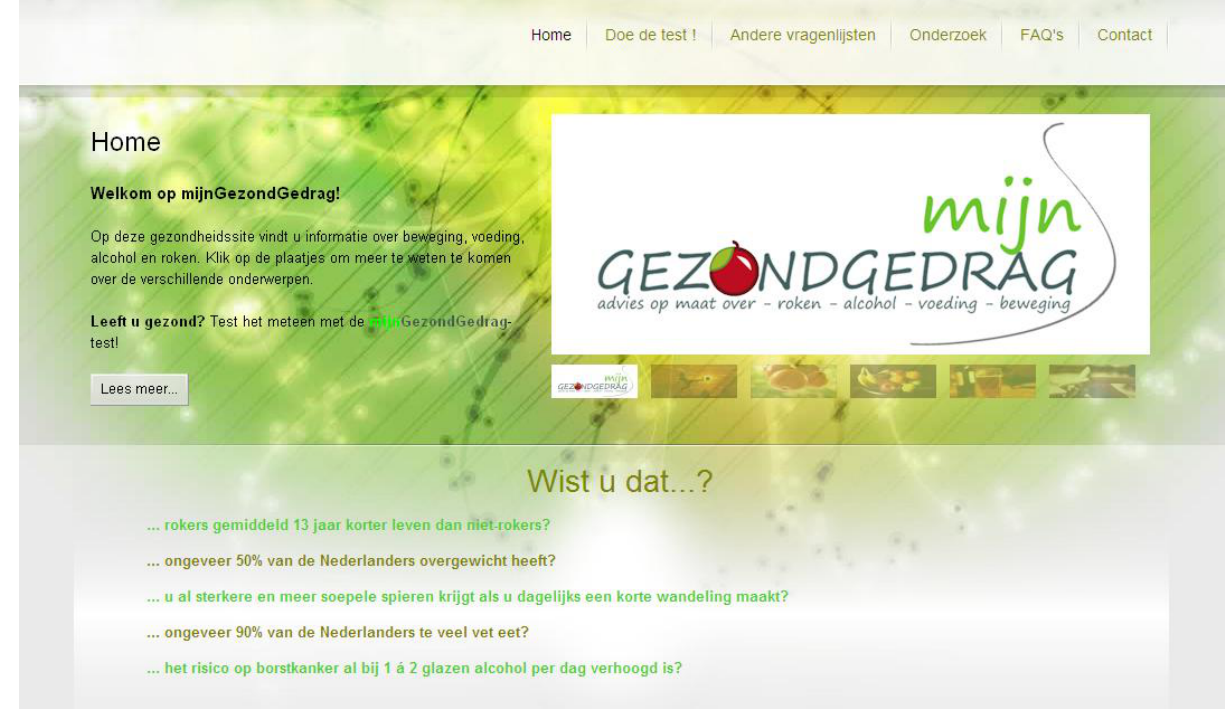
Figure 1. Screenshot of the homepage of the intervention